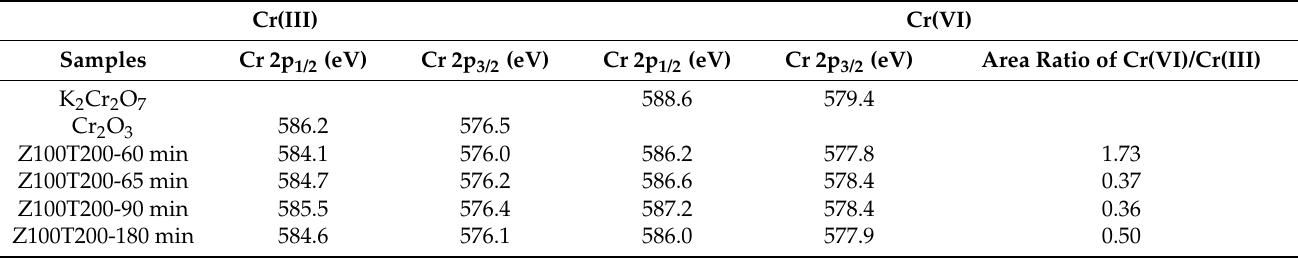
Table 3. Parameters obtained from XPS shown in Figure